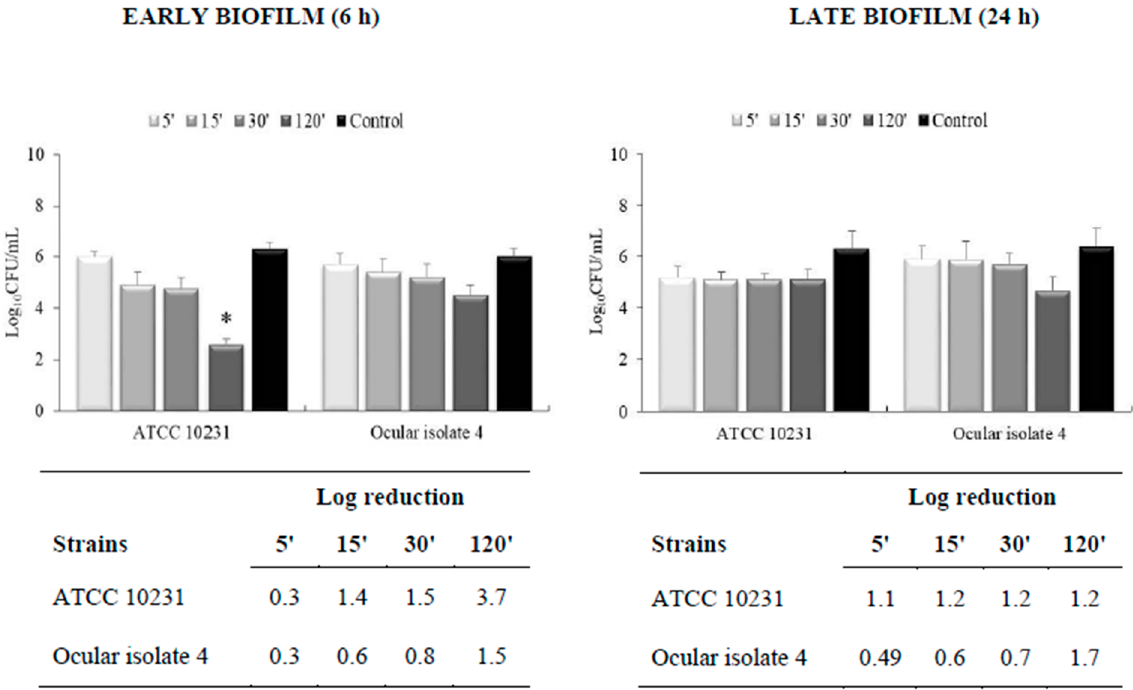
Figure 4. Quantitative measurement of C. albicans biofilm-embedded cells after treatment with the solution. Data are expressed as means ± SD of three independent experiments carried out in triplicate and relative Log reduction. *, p -value < 0.05 shows the statistical difference between treated groups and control